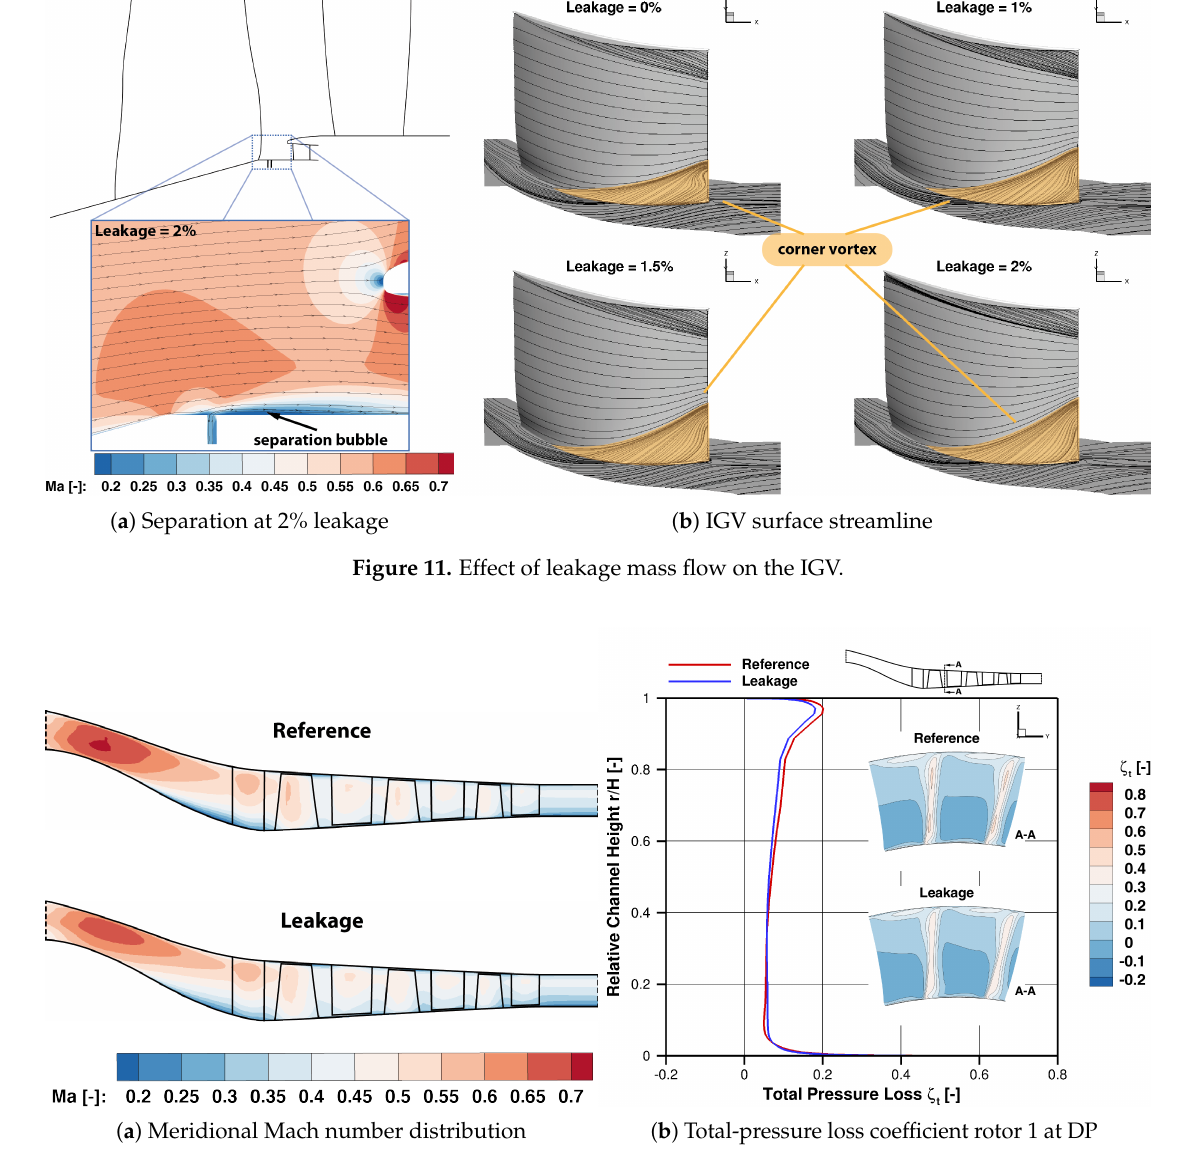
Figure 12. Effect of fan rotor cavity